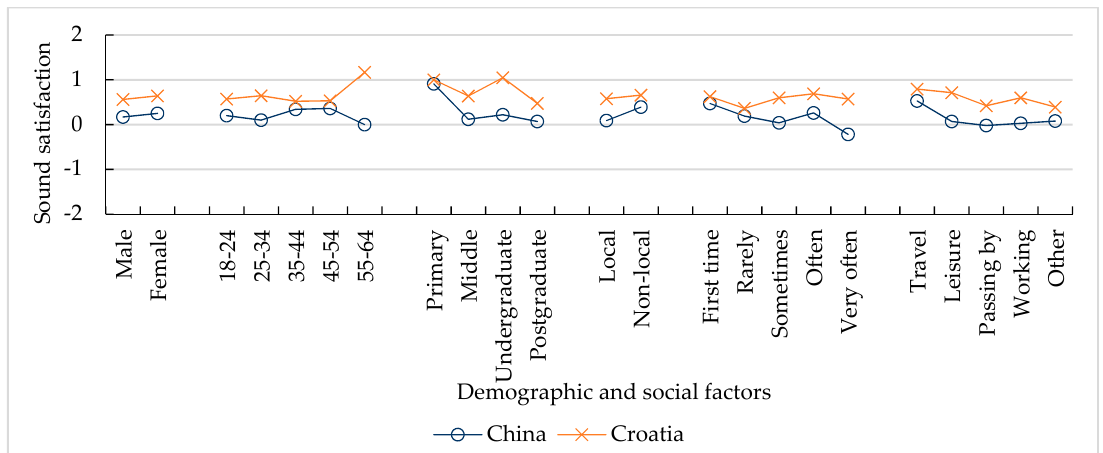
Figure 5. The sound satisfaction in terms of demographic and social factors for gender, age, living place, education, visit frequency and purpose.